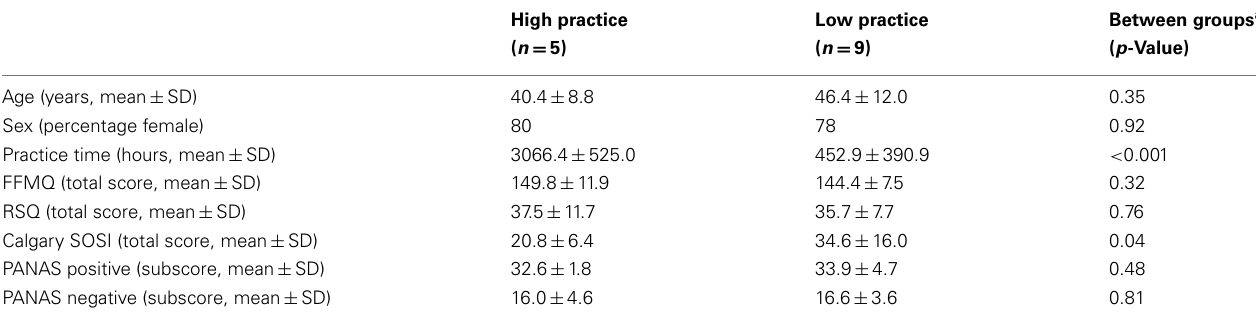
TableA1 | Demographic information.